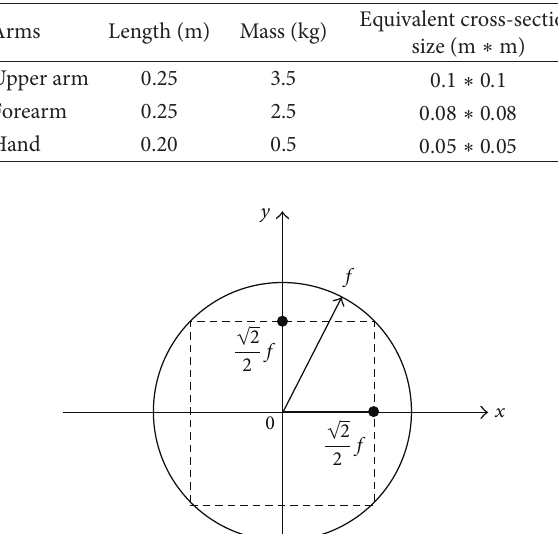
Table 1: Detailed parameters of the arms.